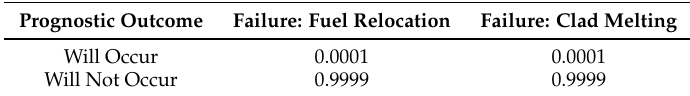
Table 4. Prognostics outcome for reactor with high power-to-flow